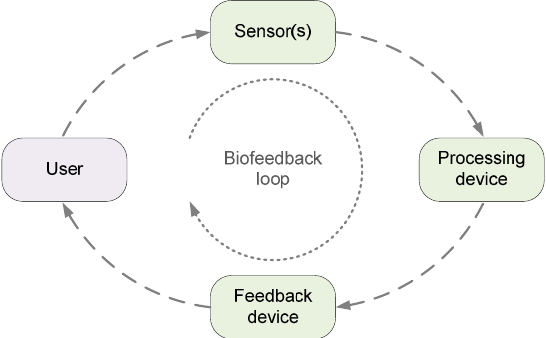
Figure 1. Operation of the biofeedback system. The user starts to execute a movement. One or more sensors attached to the user feed their signals to the processing device for real-time signal analysis. The analysis results drive the feedback device activity. The user may react to the feedback signals (audio, video, or tactile), ideally by correction of the unwanted action, but most likely by interrupting the action and correcting it in the next try. User (re)action alters the sensor signals, thus closing the feedback loop of the system.